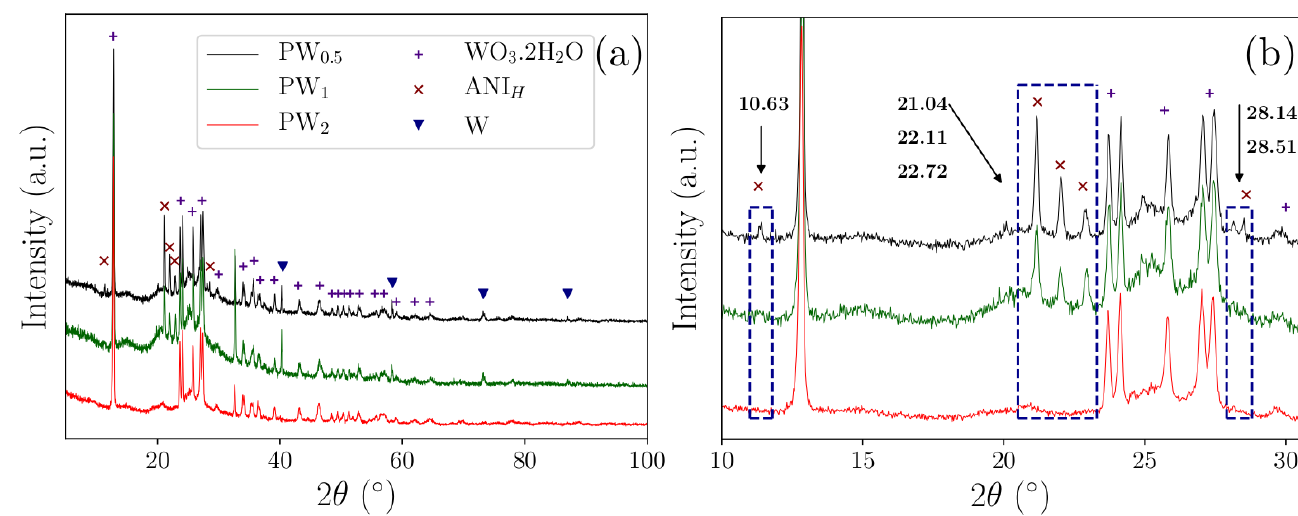
Figure 1. XRD patterns of PW 0.5 , PW 1 and PW 2 nanocomposites: ( a ) Diffraction peaks highlighting individual phases as- signed to ES–PANI, aniline hydrochloride and WO 3 ·2H 2 O, in addition to residual metallic W; ( b ) Angular region (in 2 θ ) from 10° to 30° for better visualization of the diffraction peaks.